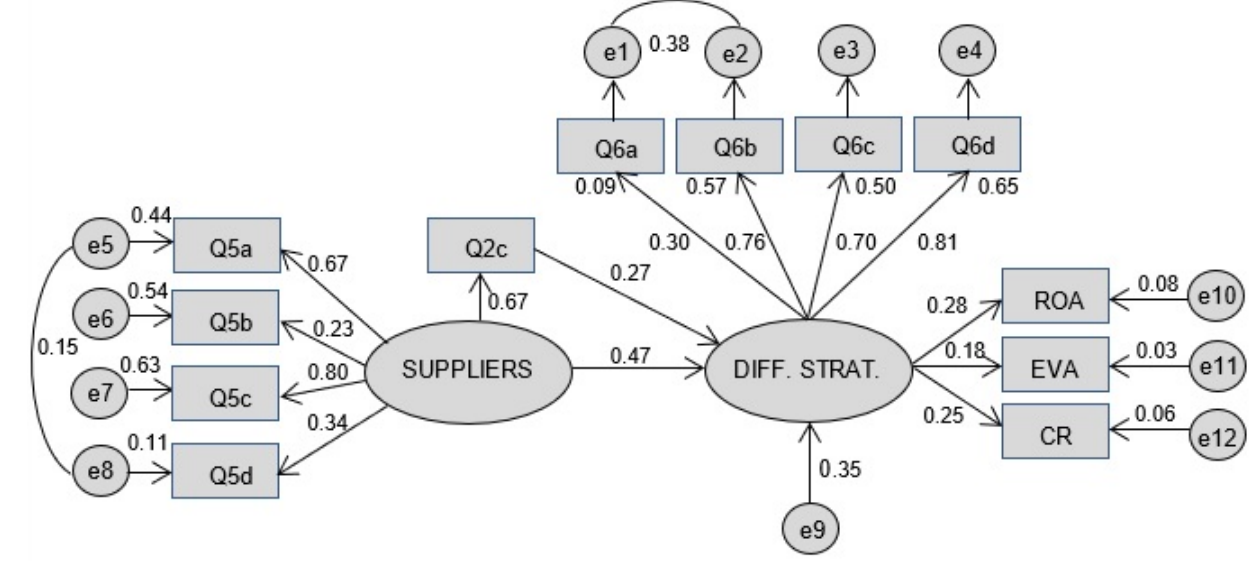
Figure 1. Structural equation model of the validation. (DIFF. STRAT.—differentiation strategy; ROA—return on assets; EVA—economic value added; CR—credit rating; e—error; p = 0.000)